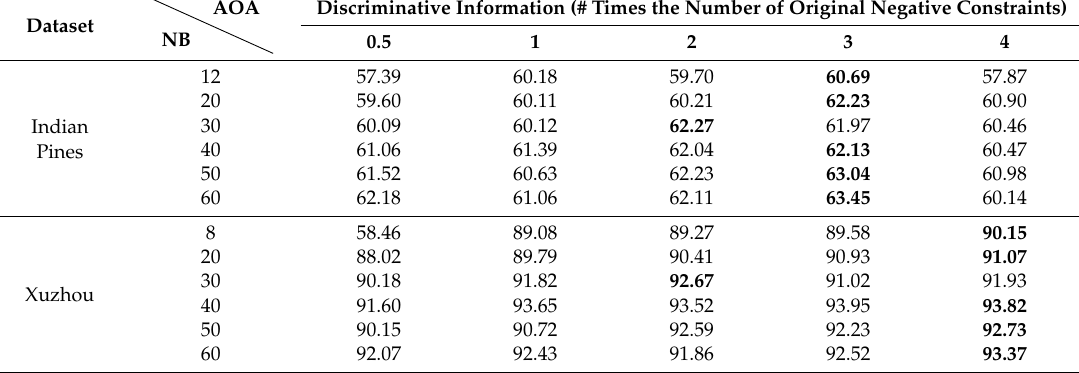
Table 3. AOA of the proposed DFM-AP compared to the number of negative constraints with different numbers of selected bands (NB) for the Indian Pines and Xuzhou datasets. Dataset NB